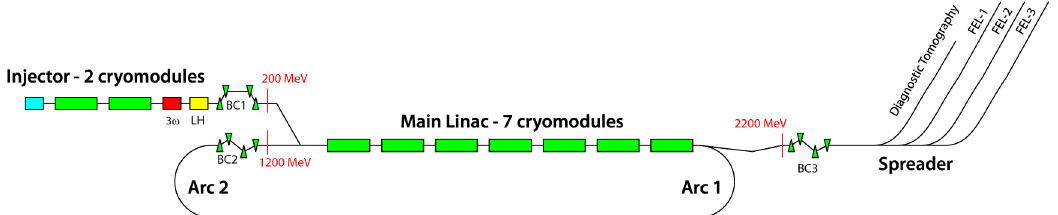
FIG. 1. Schematic layout of the NLS recirculating